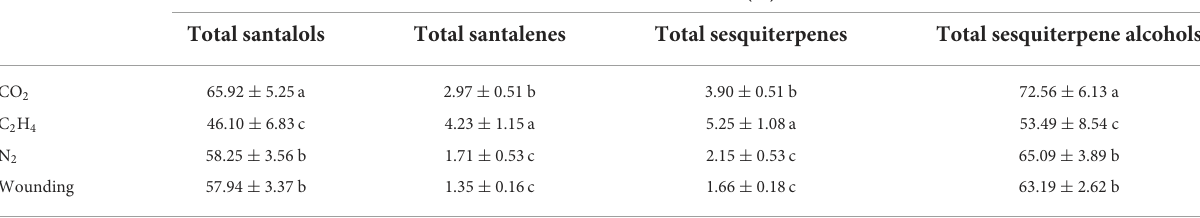
TABLE 3 ANOVA results of major ingredient group of essential oil induced by different gas treatments.